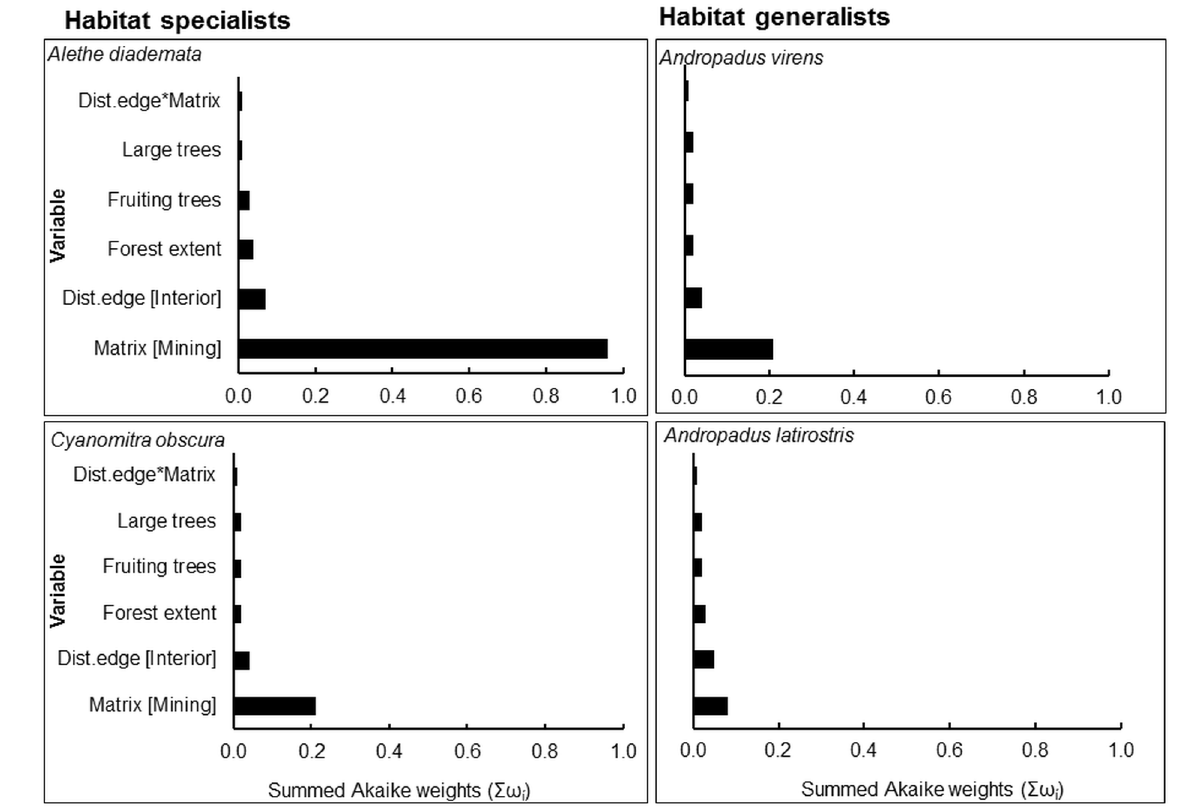
Fig 2. Summed Akaike weights ( Σω i ) from model averaging of each explanatory variable and their relative importance in influencing elevated chronic stress as indicated by H/L ratio of both habitat specialists and generalists.